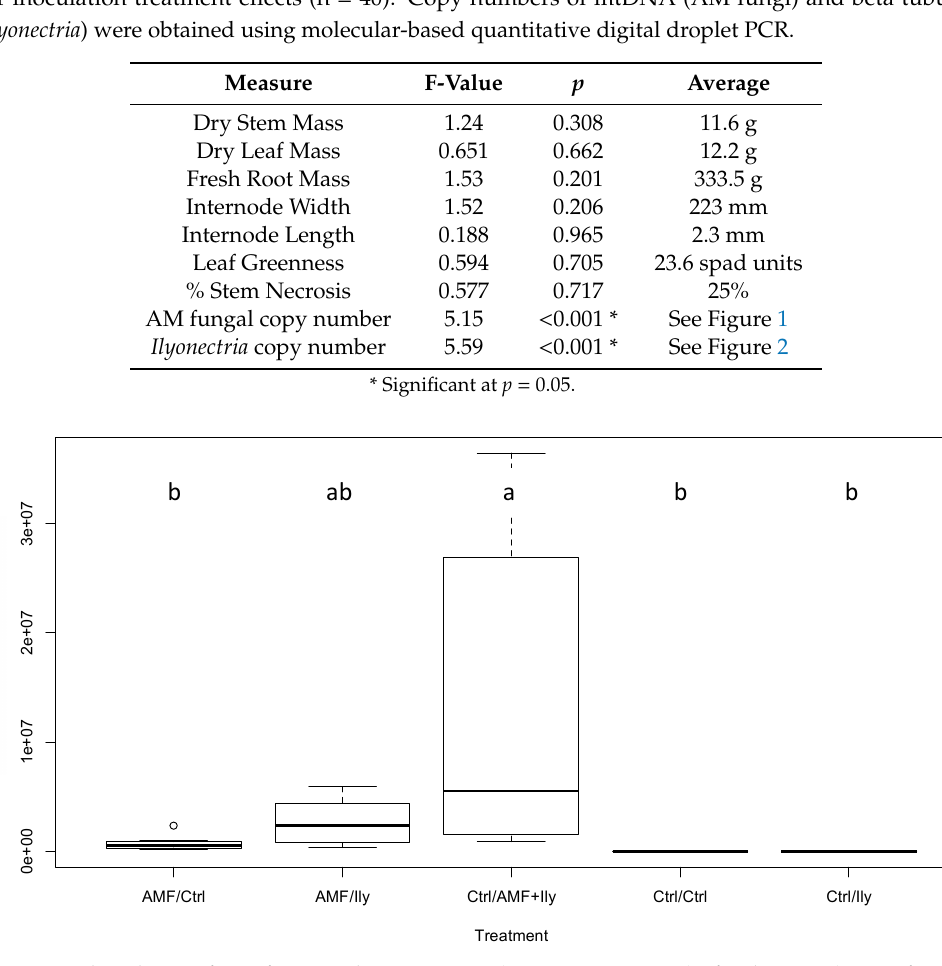
Figure 1. Abundance of AM fungi within vine roots (copies mtDNA / µ L) after harvest (6 mo after the second inoculation) in response to inoculation treatments. Treatments: Ctrl / Ctrl, non-microbial control; Ctrl / Ily, pathogen control inoculated with only Ilyonectria ; AMF / Ctrl, mycorrhizal control inoculated only with AM fungi; AMF / Ily, pre-inoculated with AM fungi followed later by Ilyonectria inoculation; and Ctrl / AMF + Ily, co-inoculated with AM fungi and Ilyonectria . Values were obtained by ddPCR and di ff erences determined using one-way ANOVA (F 5,41 = 5.135, p < 0.001), with di ff erences at p < 0.05 indicated by letters above bars (Tukey’s multiple comparison via general linear hypothesis).